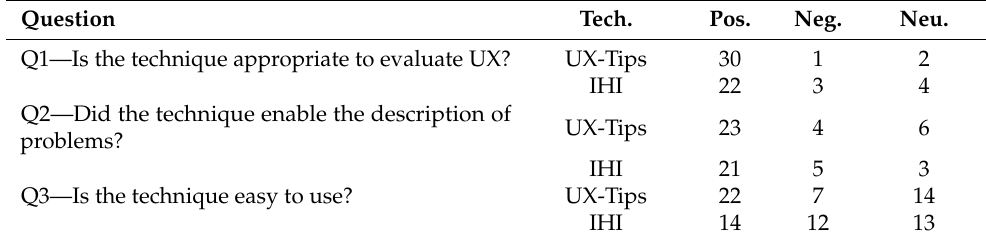
Table 16. Distribution of the user perceptions by